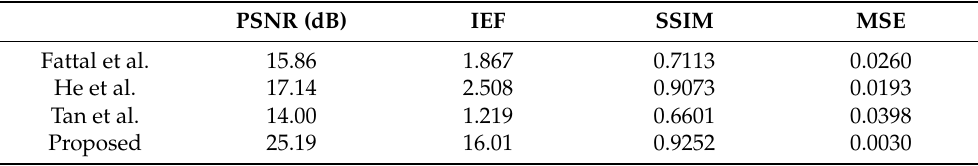
Table 5. Comparison result 2 using middle image from Figure 15.